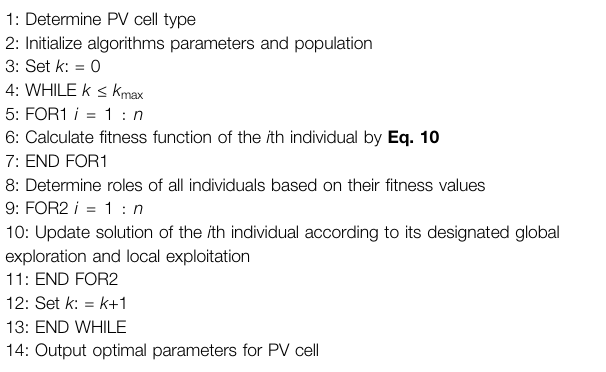
TABLE 2 | Execution procedure of DPMhA for PV cell parameter